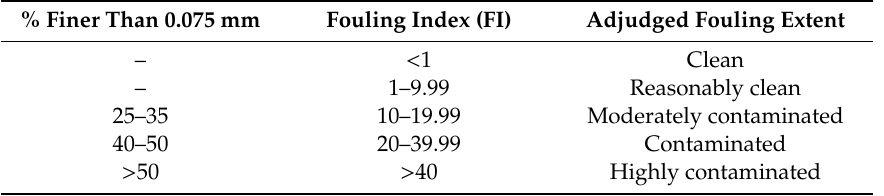
Table 2. Extent of ballast fouling as a function of computed FI values